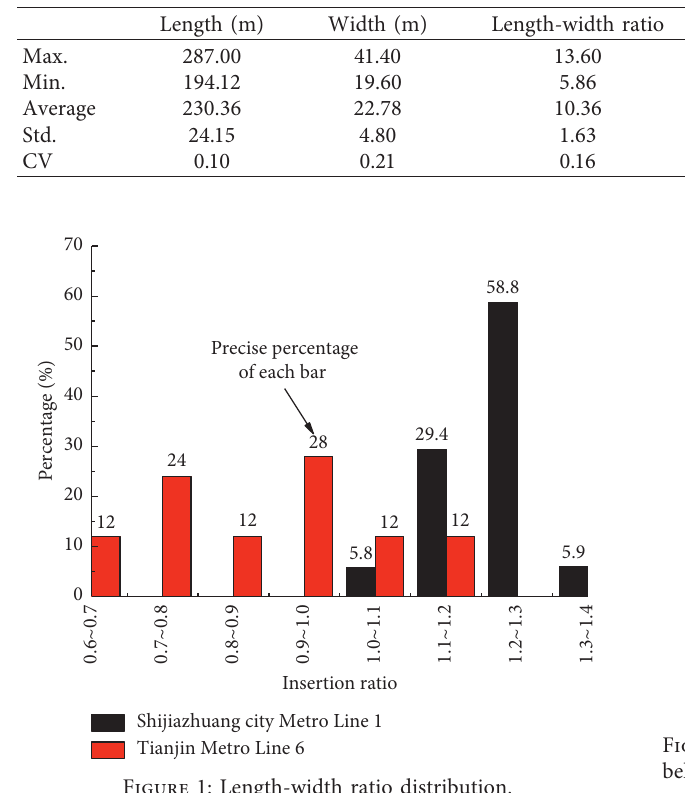
Figure 1: Length-width ratio distribution.